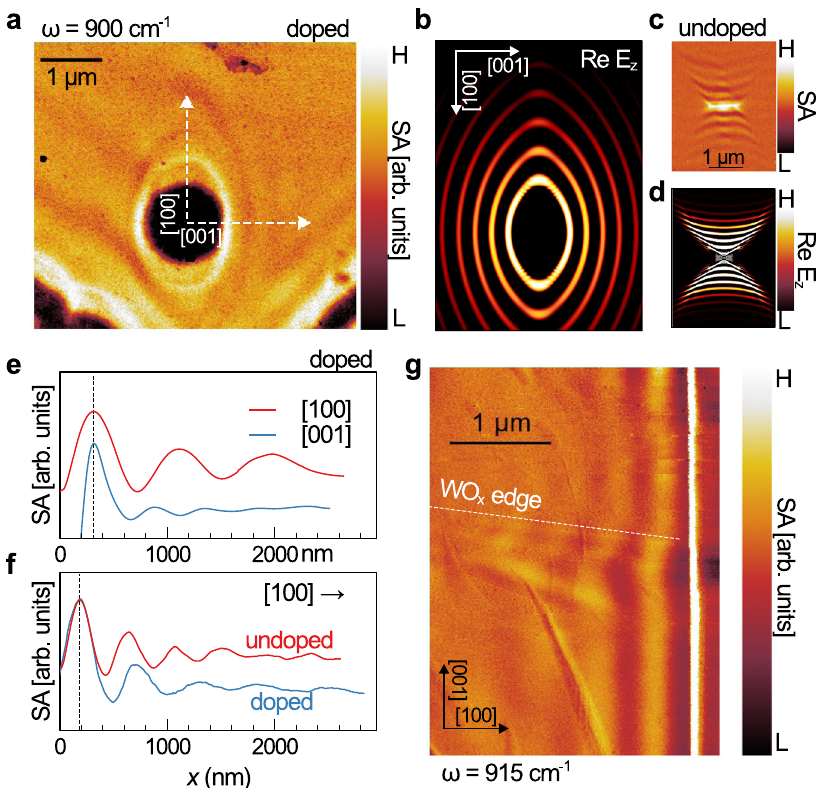
Fig. 2 Near- fi eld infrared imaging of hybrid plasmon-phonon modes. a , b Near- fi eld amplitude image of a WO x /graphene/ α -MoO 3 heterostructure with ~0.60 eV hole doping in graphene from charge transfer with the WO x monolayer. The experimental polariton wavefront displays the characteristic elliptical shape from fi nite-difference time-domain simulations shown in panel b to the right. c Near- fi eld amplitude image and, d simulated wavefront of a defect in bare α -MoO 3 launching hyperbolic wavefronts — in contrast to the closed wavefront in a where [001] modes appear after the topological transition caused by plasmon-phonon hybridization. e Line pro fi les extracted along the white dashed lines in a showing both [100] and [001] modes. Black dashed lines align the fi rst peaks. f [100] Line pro fi les extracted from either side of the WO x edge (white dashed line) in g . Wavelengths of [100] modes increase as a result of plasmon-phonon hybridization upon